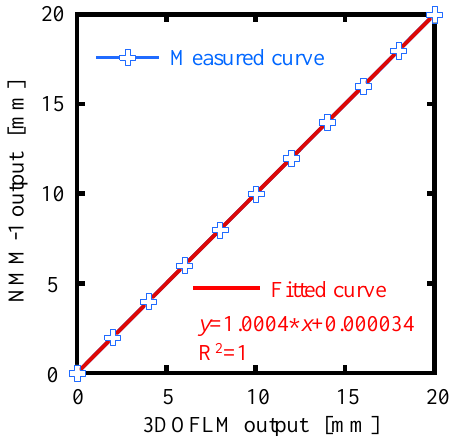
Figure 13. Comparison results of measured displacement by the NMM-1 and 3DOFLM systems without wavelength correction.